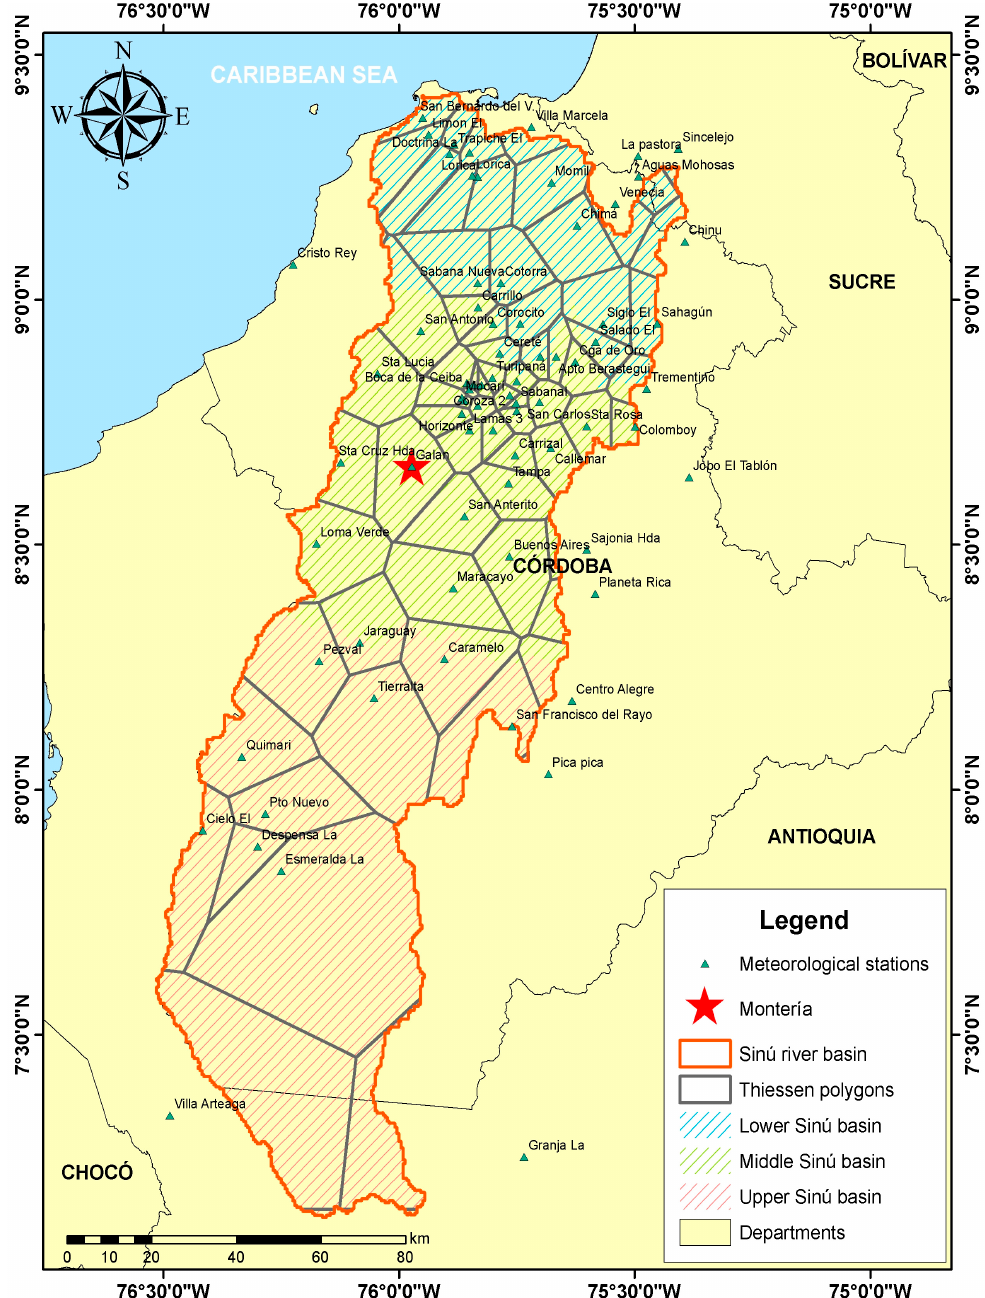
Figure 2. Spatial locations of the selected rainfall stations and Thiessen polygons for the 75 selected stations in the Sinú river watershed (Colombia).